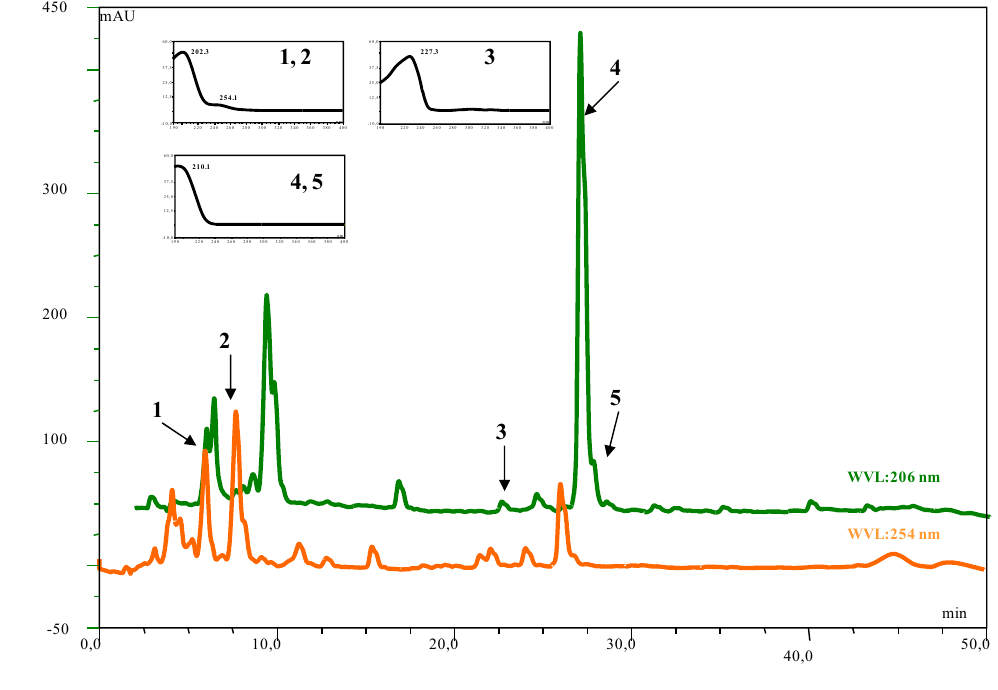
Figure 1. UV spectra at 206 and 254 nm of DvA with UV spectra of 1) inuviscolide, 2) tomentosin, 3) ilicic acid, 4) costic acid, 5) 3 α -hydroxy costic